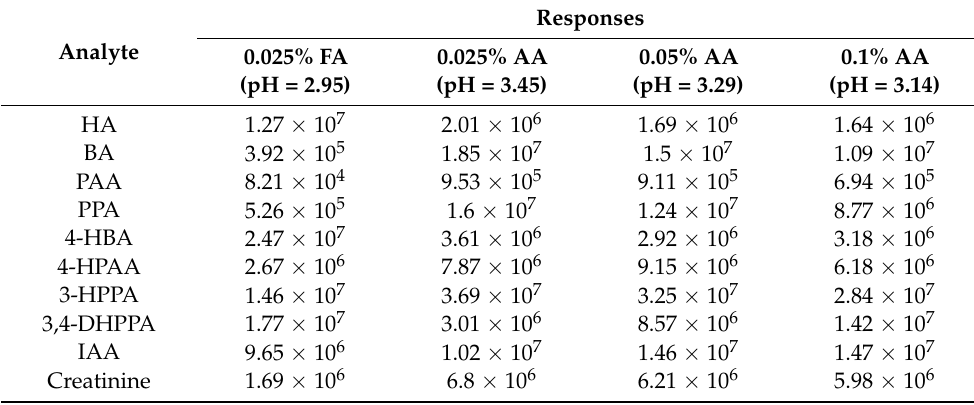
Table 1. Effects of formic acid and acetic acid on negative-ion ESI responses of nine organic acids and positive-ion ESI responses of creatinine at 1 µ